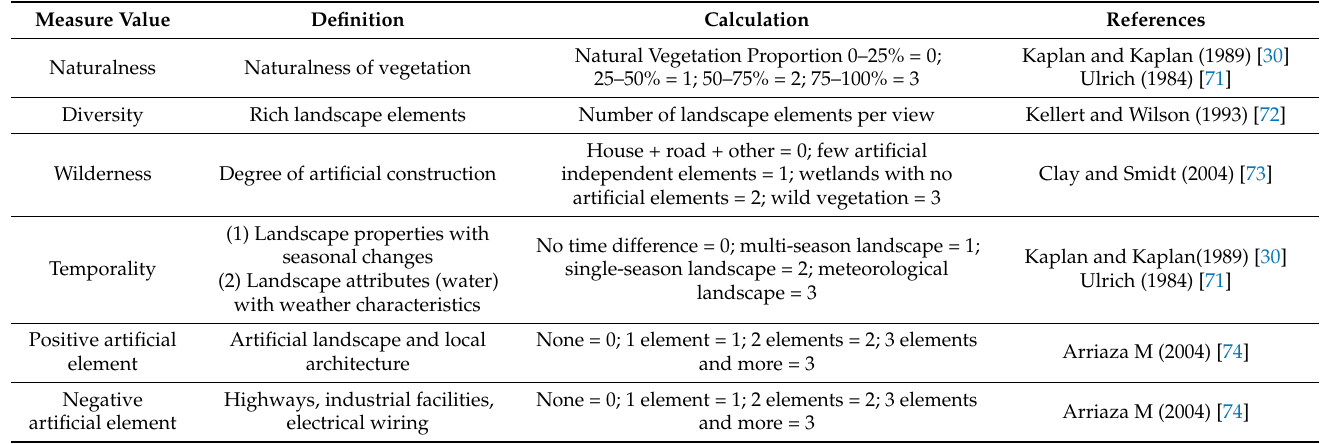
Table 2. Visual preference metrics and scoring principles [69].